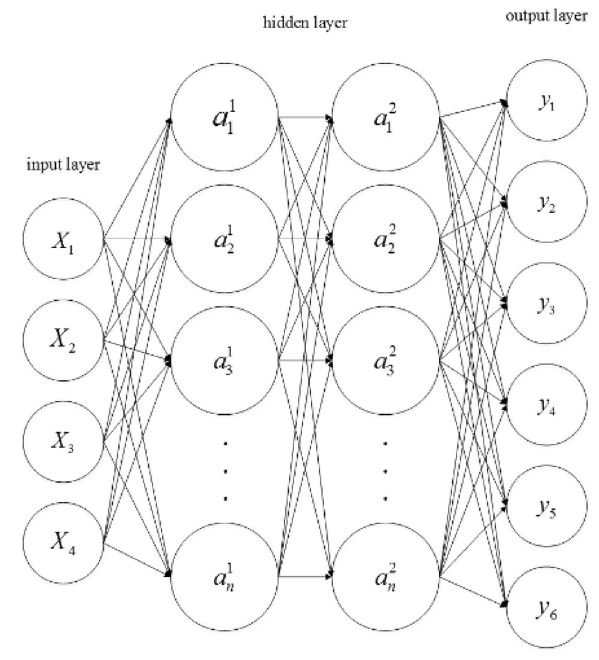
Fig. 8 3-layer DNN